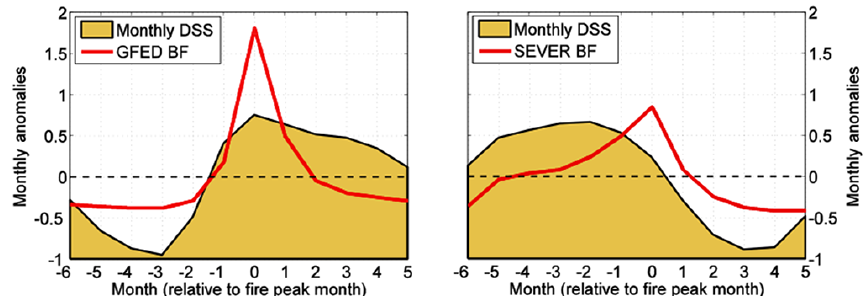
Figure 11. Averaged correspondence of fire season with dry season anomalies over regions of sub-Saharan Africa with a delay in peak month superior or equal to 4.